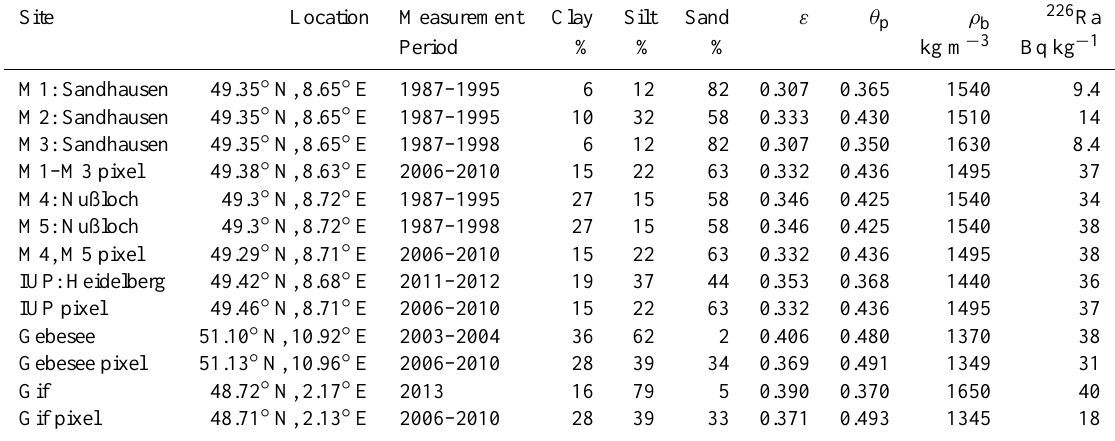
Table 2. Characteristics of the long-term 222 Rn flux sampling sites from IUP (compare Fig. 1 and Table 1), M1–M5 close to Heidelberg as well as Gebesee, northern Germany, and Gif-sur-Yvette, France. For M1–M5, the percentage of clay, silt, and sand have been estimated from the soil type description of Schüßler (1996), according to mean percentages reported by Cosby et al. (1984, Table 2); the 226 Ra activity concentrations have been reported by Schüßler (1996). For IUP, Gebesee and Gif-sur-Yvette, these parameters were measured by Schwingshackl (2013). For comparison with measurements, we also list the data for the respective pixels from the high-resolution map of soil parameters (“pixel”) ( ε : emanation coefficient, θ p : soil porosity, ρ b : dry bulk